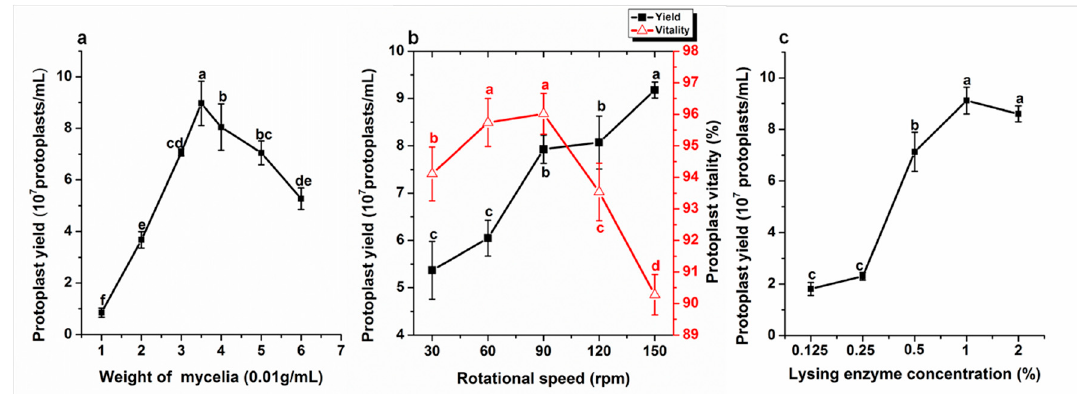
Figure 2. ( a ) Effects of mycelia weight on protoplast yield; ( b ) effects of rotational speed on protoplast isolation; and ( c ) effects of concentration of lysing enzyme on protoplast yield. Data represent the mean ± standard errors (SE) of three independent experiments. Different lower-case letters indicate significant difference ( p < 0.05).